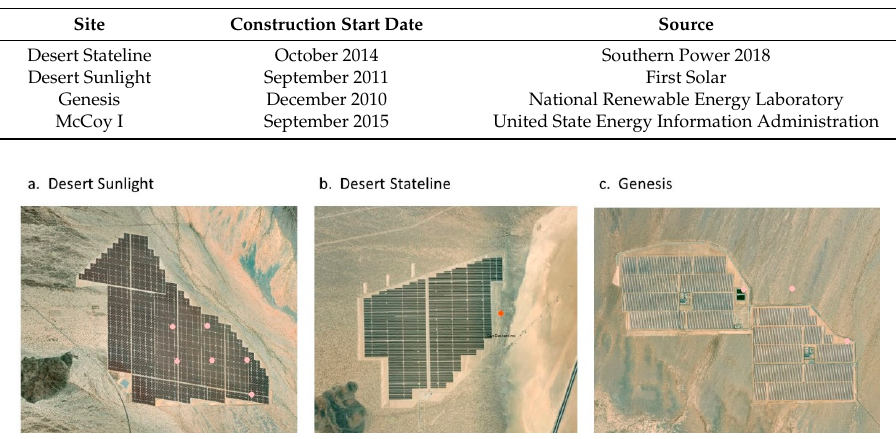
Figure 5. Map of single breakpoints (shaded circle symbols) detected from structural change analysis of LST at solar energy construction facilities in the Lower Colorado Desert. All maps are upward in the northern direction.